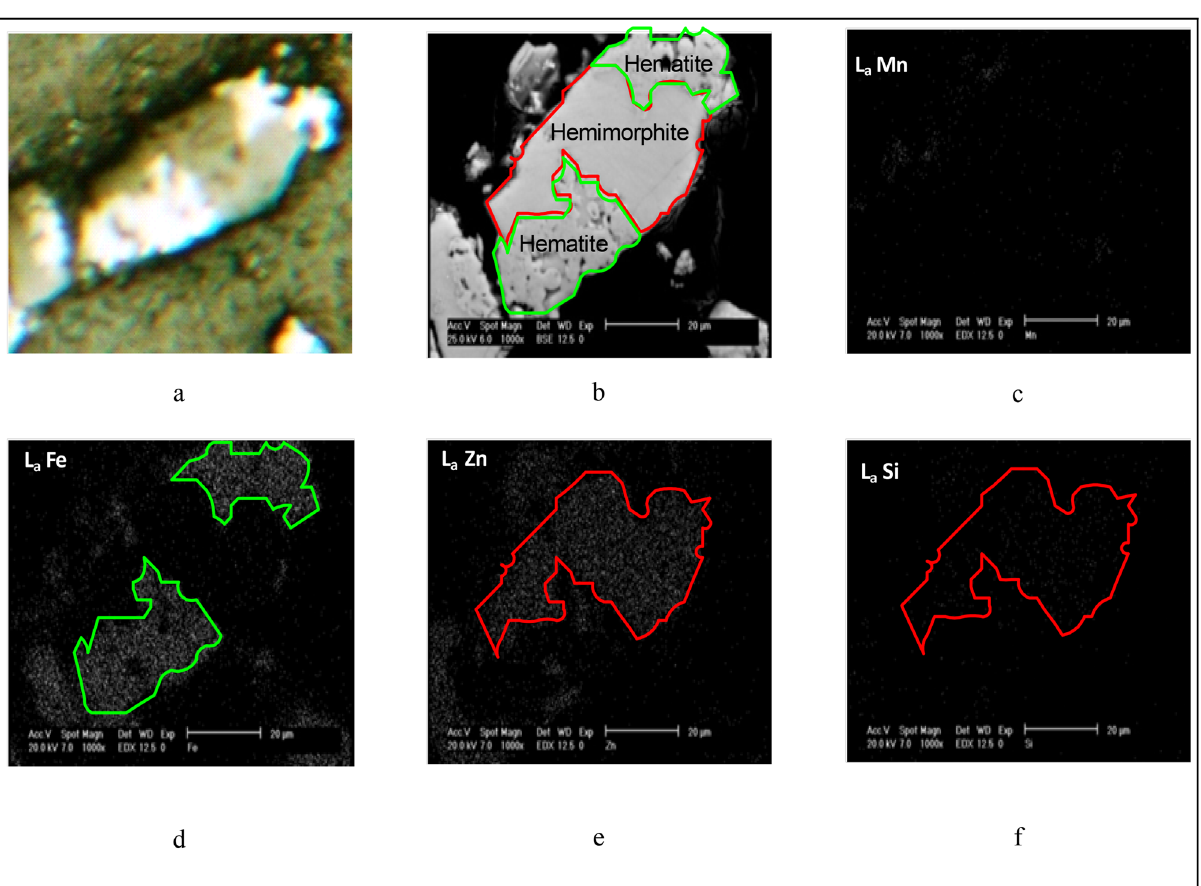
Figure 3. Hemimorphite association with hematite ( a ) microscopic image, ( b ) BS image by SEM, ( c ) WDX image of manganese, ( d ) WDX image of iron, ( e ) WDX image of zinc, ( f ) WDX image of